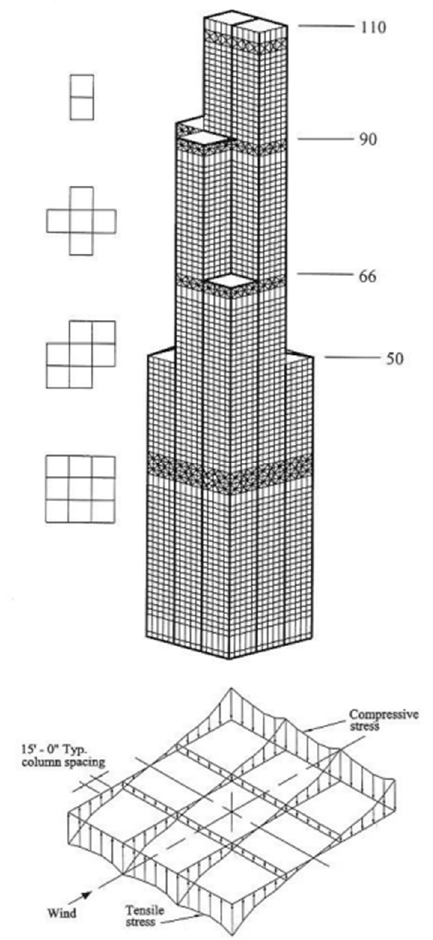
Figure 9. Bundled Tube building. The Sears Tower in Chicago. (Source: [5], pp. 124–125).